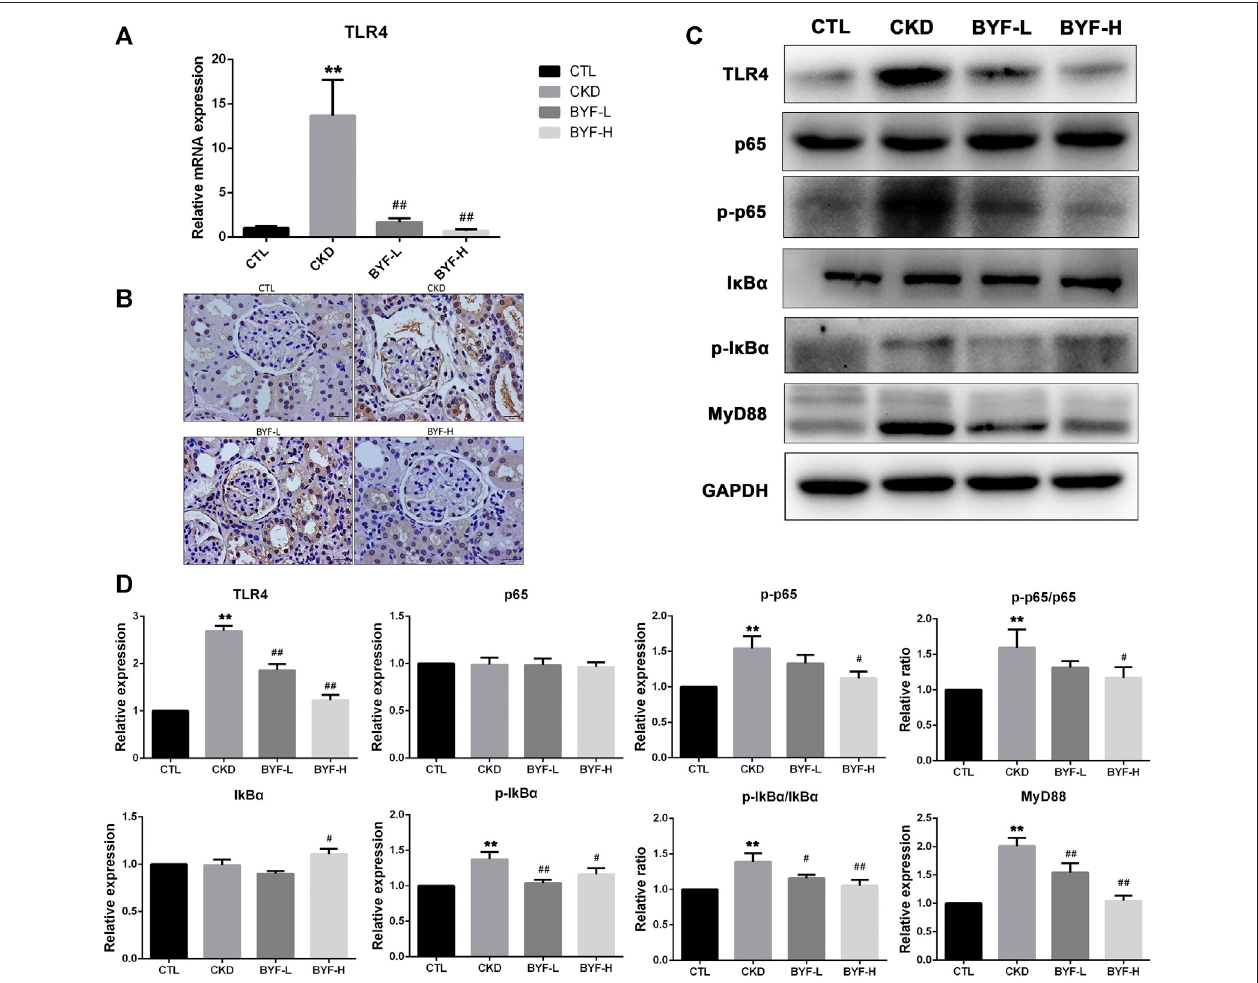
FIGURE 5 | BYF suppresses TLR4/NF- κ B signaling pathway in adenine-induced CKD rats. qPCR validation of TLR4 (A) and immunohistochemical staining of TLR4 (B) inindicatedgroups.TLR4,p65,p-p65,IK βα ,p-IK βα ,andMyD88WBvalidation (C) andquantitativeanalysis (D) inindicatedgroups.Allvaluesarepresentedas means ± SD. n (cid:1) 3 rats per group. * p < 0.05 and ** p < 0.01 vs. the CTL group; # p < 0.05 and ## p < 0.01 vs. the CKD group.